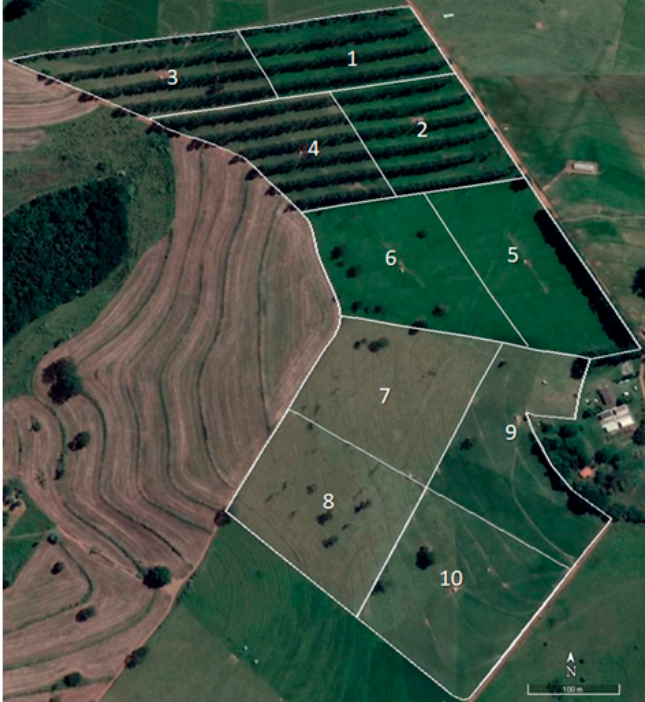
Figure 1. Experimental area divided into the respective treatments: (1–2) iCLF: integrated crop– livestock–forest system; (3–4) iLF: integrated livestock–forest system; (5–6) iCL: integrated crop– livestock system; (7–8) EXT: extensive; (9–10) INT: intensive.